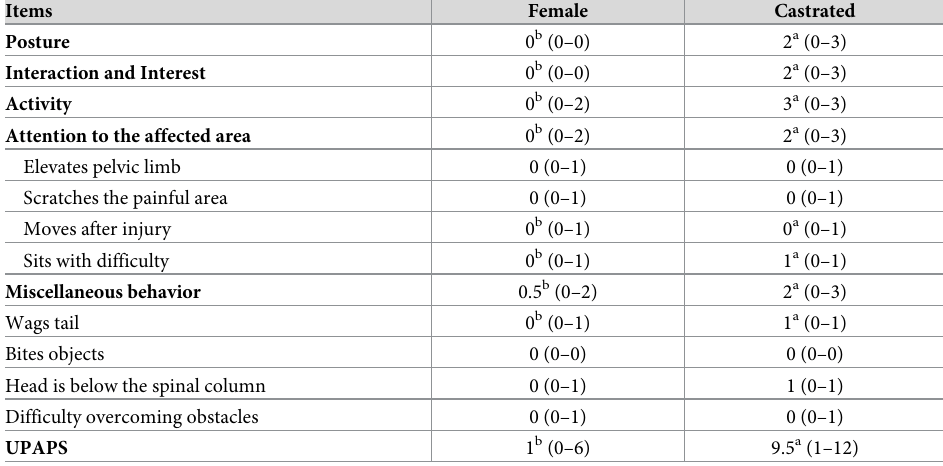
Table 9. Median (amplitude) of the UPAPS scores for castrated (n = 14) and non-painful female piglets (n = 6) awake piglets at M2.